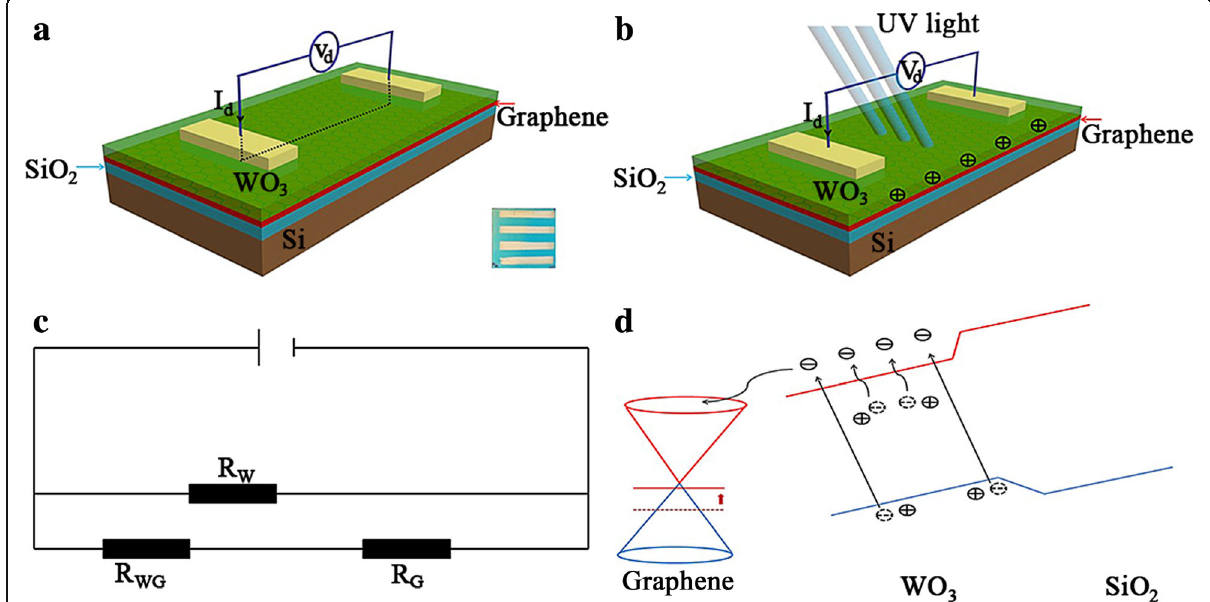
Fig. 6 Characteristics of WO 3 /GR after photo-induced modulation doping. a , b Current route and charge distribution in the WO 3 /GR device in case of UV light. Positive charges accumulate in WO 3 under light illumination. Yellow, Cr/ Au; green, WO 3 ; red, graphene; blue, SiO 2 ; gray, Si. c Equivalent circuit model of the WO 3 /GR device. d Schematics of the band structure of the WO 3 /GR heterostructure and illustration of the photodoping mechanism, in which optical excitation first excites electrons from defects in WO 3 . Red (blue) lines represent the conduction (valence) band. The excited electrons enter the graphene, and the positively charged defects lead to modulation doping in the